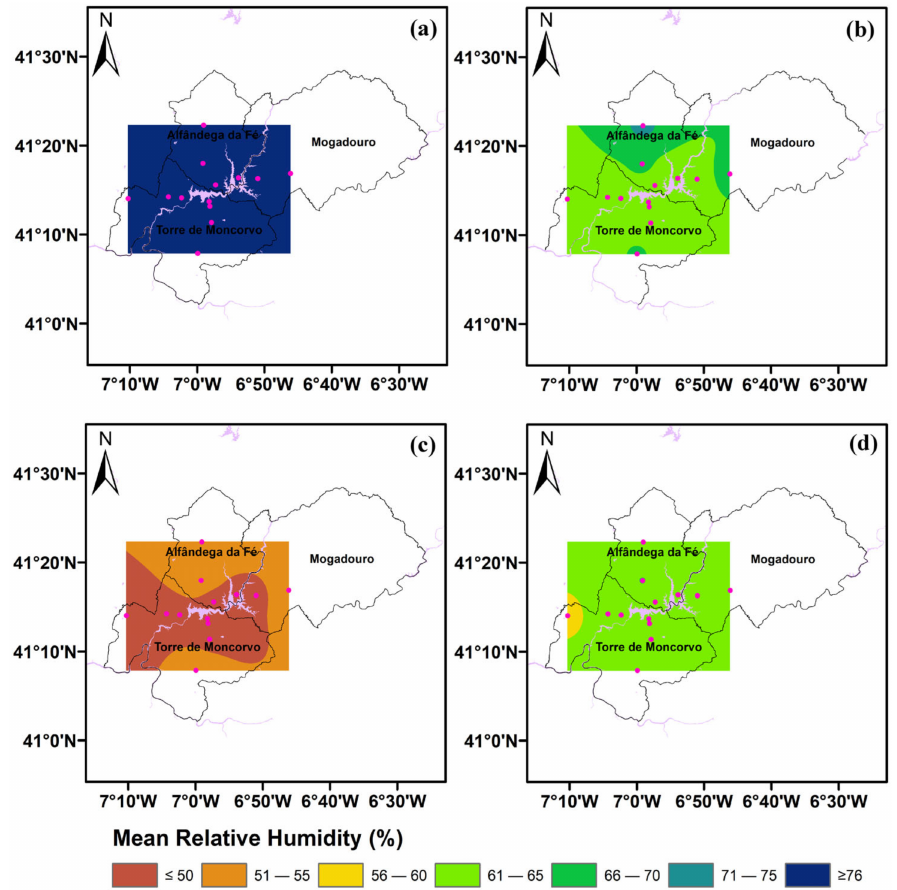
Figure 4. Spatial distribution of mean relative humidity in the target region of the Baixo Sabor Hydroelectric Plant (BSHP) for the period 2011–2020: ( a ) winter; ( b ) spring; ( c ) summer; and ( d )